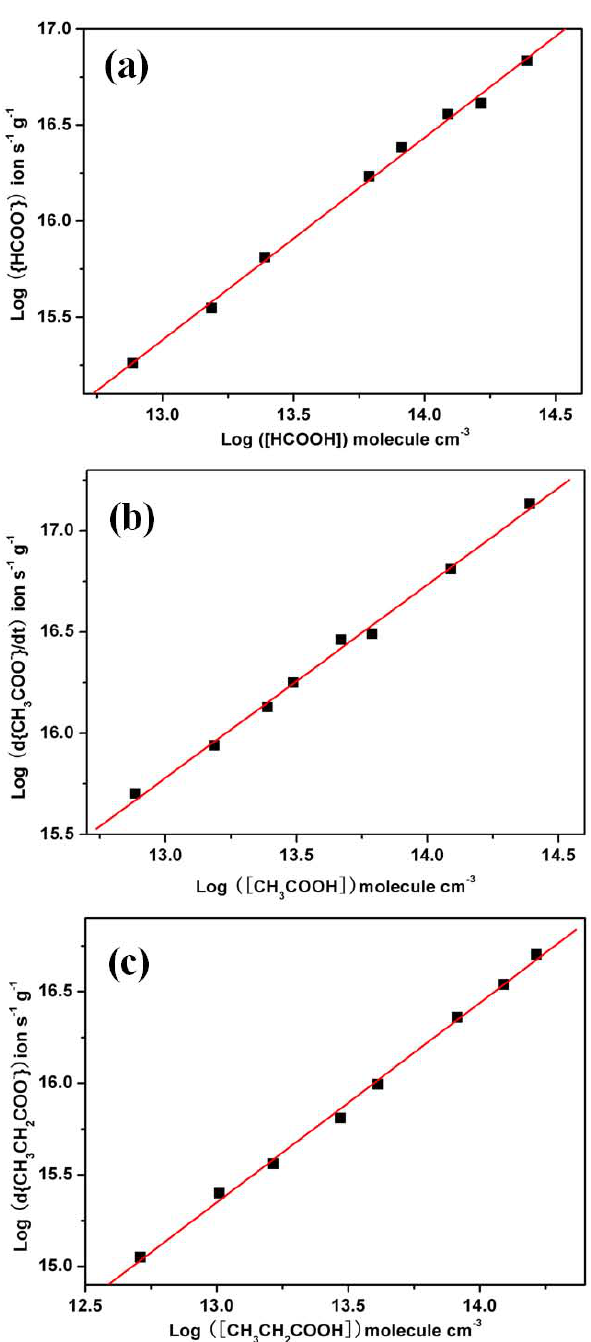
Fig. 5. Bilogarithmic plot of the rate of carboxylates formation as a function of the concentration of (a) HCOOH, (b) CH 3 COOH, and (c) CH 3 CH 2 COOH. The reaction order in HCOOH, CH 3 COOH, and CH 3 CH 2 COOH was determined from linear regression to be n =1.05 ± 0.02 (RSD=3.26%), n =0.95 ± 0.03 (RSD=3.27%), and n =1.09 ± 0.02 (RSD=3.37%),